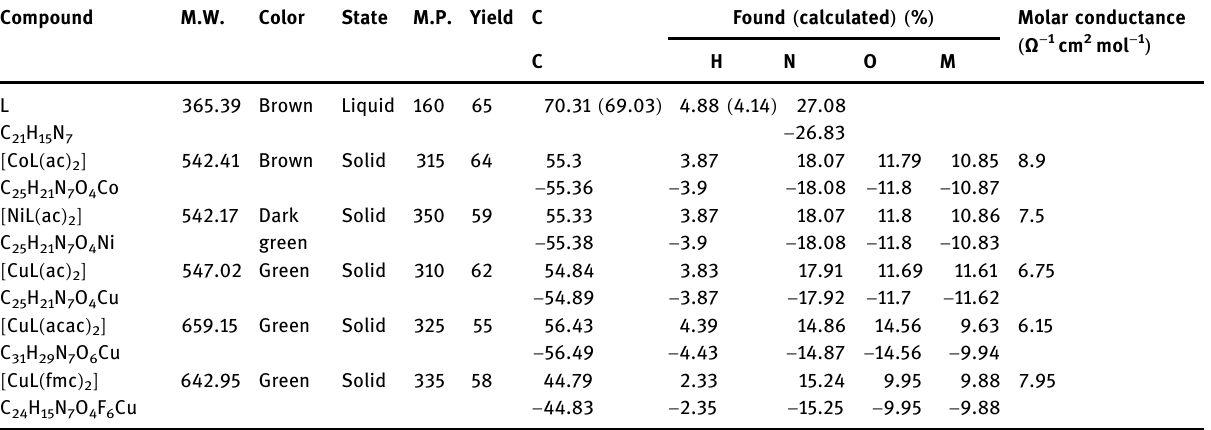
Table 1: Analytical and physical data of the Schi ff base and its metal complexes